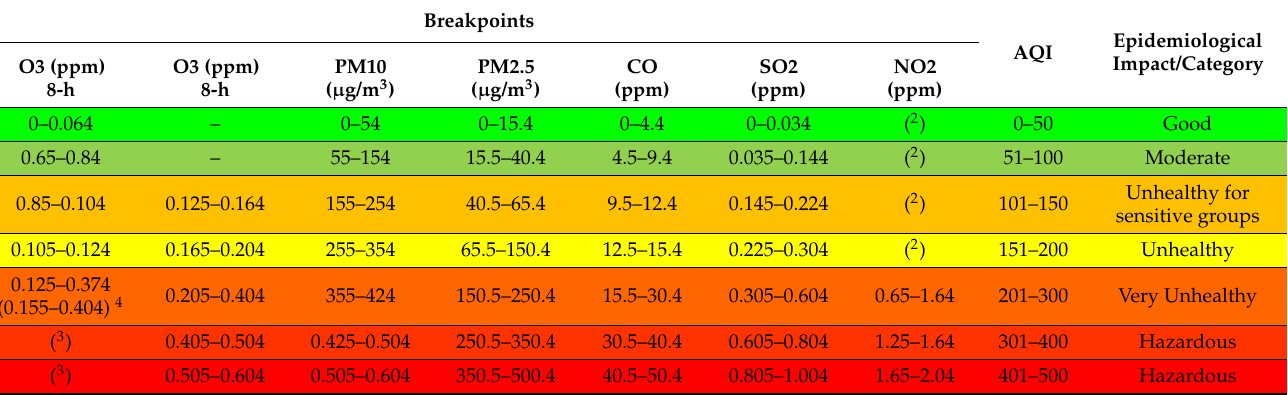
Table 3. Pollutants and Epidemiological Baseline